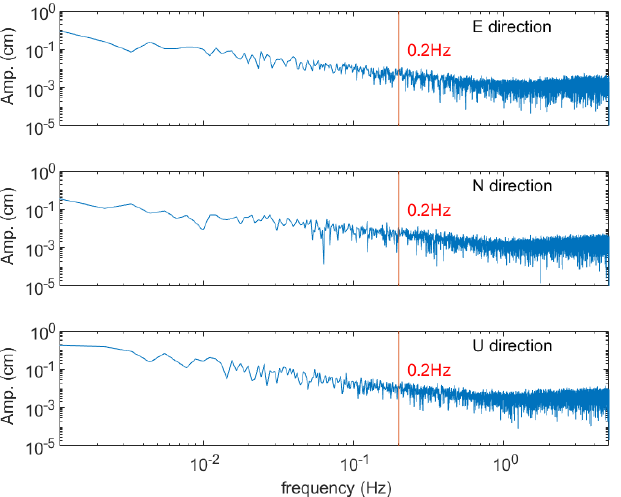
Figure 10. FFT spectrum of vibrational displacements at station NCCU in 22:40 – 22:55 (GPS time).